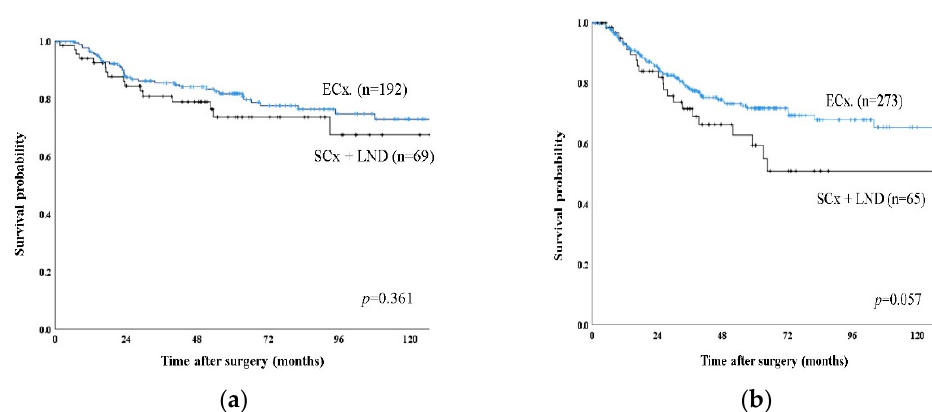
Figure 2. Disease specific survival curve of T2 GBC according to type of operation between extended cholecystectomy (ECx) and simple cholecystectomy with lymph node dissection (SCx+ LND). ( a ) Kaplan–Meier plots of patients with T2a showing no difference in 5-year disease specific survival between ECx and SCx + LND. ( b ) Kaplan–Meier plots of patients with T2b showing a better survival trend without statistically significant in ECx than in SCx + LND.